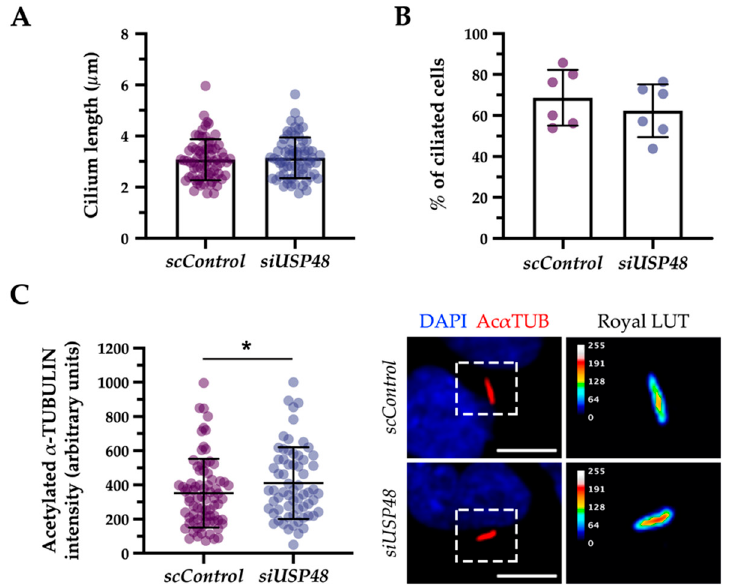
Figure 4. The knock-down of USP48 does not alter ciliogenesis but increases the intensity of ciliary acetylated α -tubulin in hTERT-RPE1 cells. No significant differences were detected in hTERT-RPE1 cells transfected with scControl or siUSP48 with respect to ( A ) the ciliary length (Mann-Whitney test; n = 64–69; two independent experiments) and ( B ) the percentage of ciliated cells (Student’s t -test; n = 3 images with approximately 30 cells/replicate; two independent replicates). ( C ) The fluorescence intensity of the cilium acetylated α -tubulin was significantly increased in cells transfected with siUSP48 compared to the control (Mann Whitney test; * = p -value ≤ 0.05; n = 64–78; two independent replicates). At the right, representative images of scControl - and siUSP48 -transfected hTERT-RPE1 cells showing fluorescence intensity differences of acetylated α -tubulin of the cilia using the ROYAL range of colours (the calibration bar from 0 to 255 grey values is depicted). Cells were labelled with anti-acetylated α -tubulin (Ac α TUB, red) and nuclei were counterstained with DAPI (blue). All data represent the mean ± SD. Scale bar: 10 µm. LUT, lookup table.